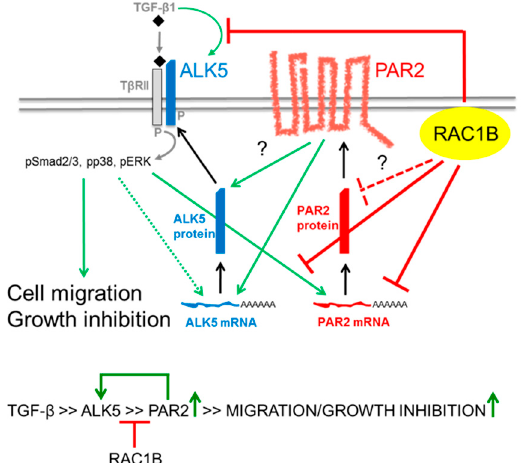
Figure 6. Schematic diagram illustrating RAC1B regulation of ALK5 via PAR2. TOP: RAC1B suppresses the abundance of basal and TGF- β 1 / ALK5-dependent mRNA (right, solid red lines) and protein (right, stippled red line) of PAR2. Reduction in the protein abundance of PAR2 leads to downregulation of ALK5 mRNA and, hence, protein abundance and / or membrane localization (center) and, thereby, of TGF- β 1-induced Smad and non-Smad signaling (top left), culminating in reduction in TGF- β -induced PAR2 gene expression (bottom right) as well as cell migration and growth inhibition (bottom left). In addition, RAC1B suppresses autoinduction of TGFBR1 by TGF- β 1 (top). Stimulatory interactions are indicated by green arrows and inhibitory interactions by red lines. Stippled lines indicate the possibility that RAC1B targets PAR2 not directly but through intermediary proteins of as yet unknown identity, while the dotted arrow indicates that ALK5 autostimulation only occurs under conditions of RAC1B inhibition. The question marks indicate possible e ff ects on protein stability independent of transcriptional events. P, phosphate residue. BOTTOM: Summary of e ff ect: RAC1B attenuates (red lines) upregulation of PAR2 by activated ALK5 (upward green arrow), which in turn a ff ects the upregulation of ALK5 (green line / arrow). The RAC1B inhibitory e ff ect on basal PAR2 expression, which is ALK5-independent (see Figure 2D), has been omitted here for reasons of